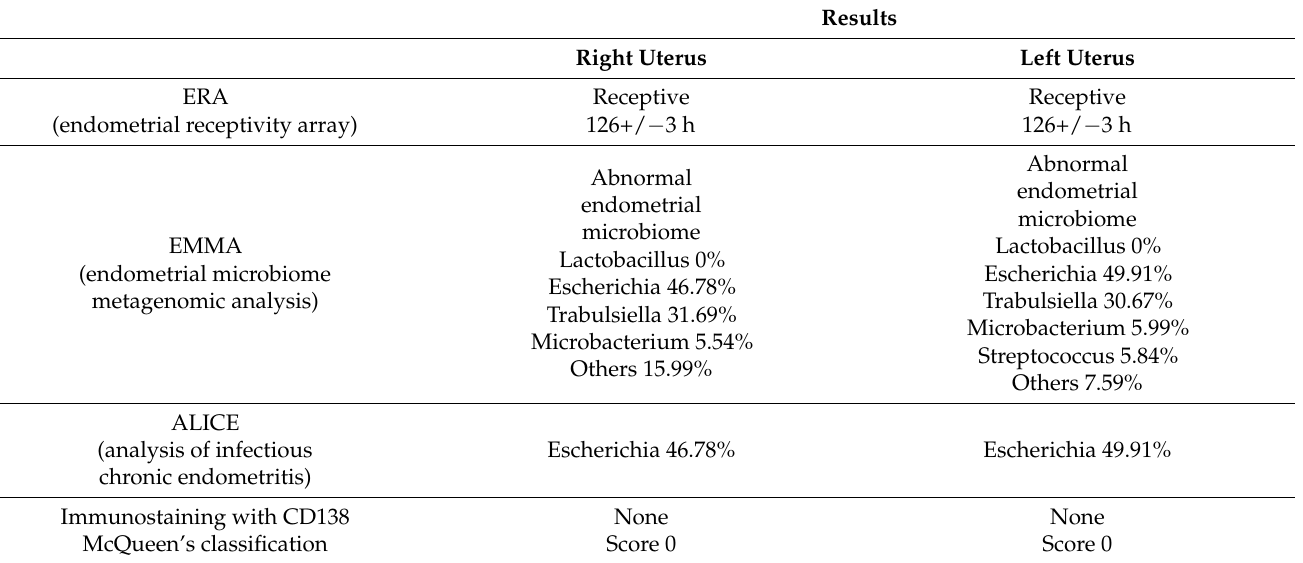
Table 1. Summary of results for evaluation of endometrial receptivity, microbiota, and chronic endometritis (CE) in both uterine